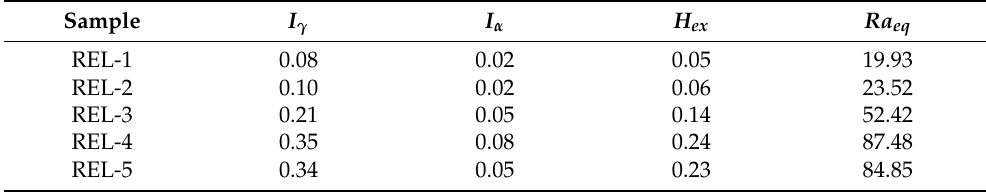
Table 5. Average values of activity indexes and radiological hazard